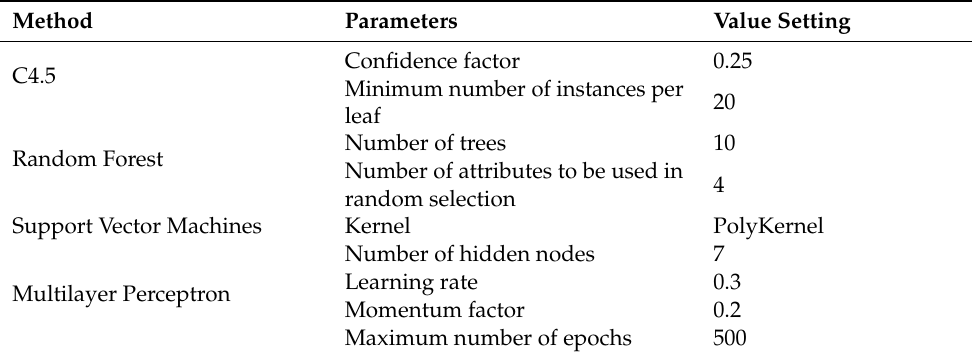
Table 1. Parameter setting in